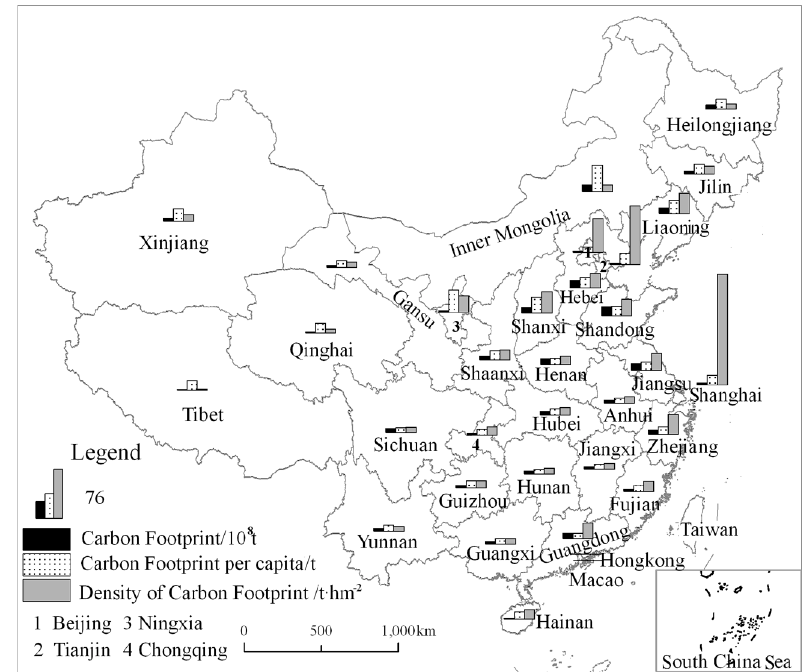
Figure 5. Spatial pattern of the carbon footprint